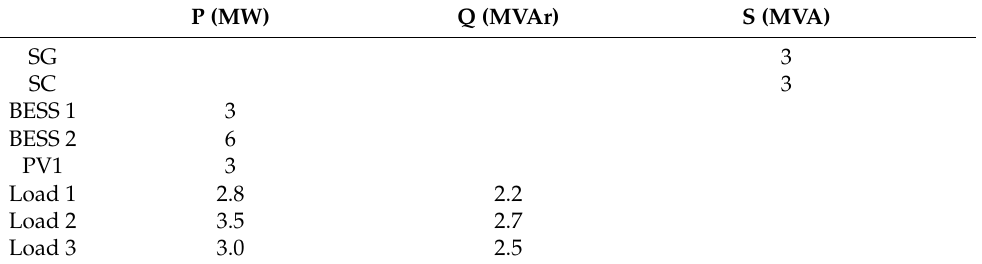
Table 1. MG parameters [17].